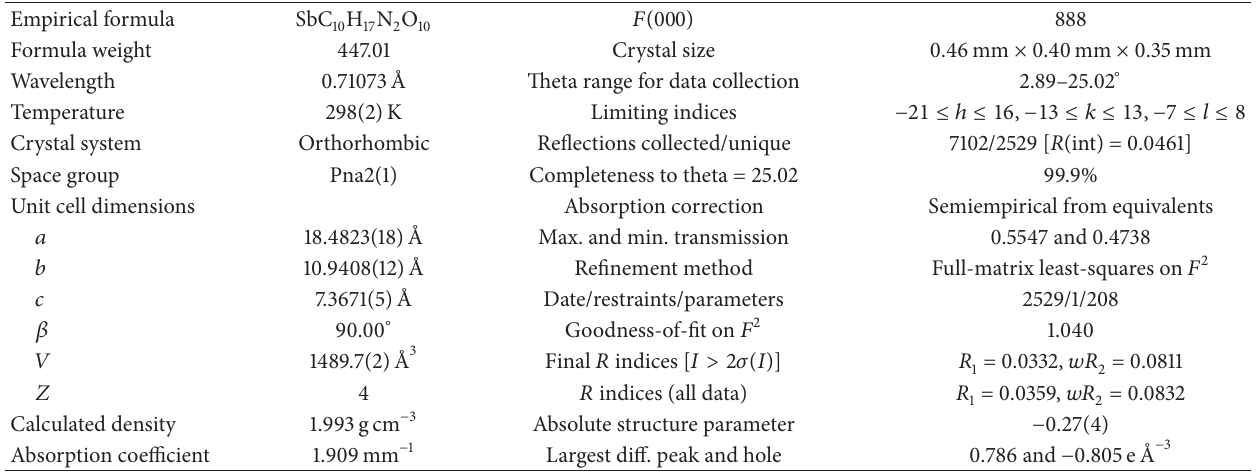
Table 1: Crystal data and structure refinement for the title